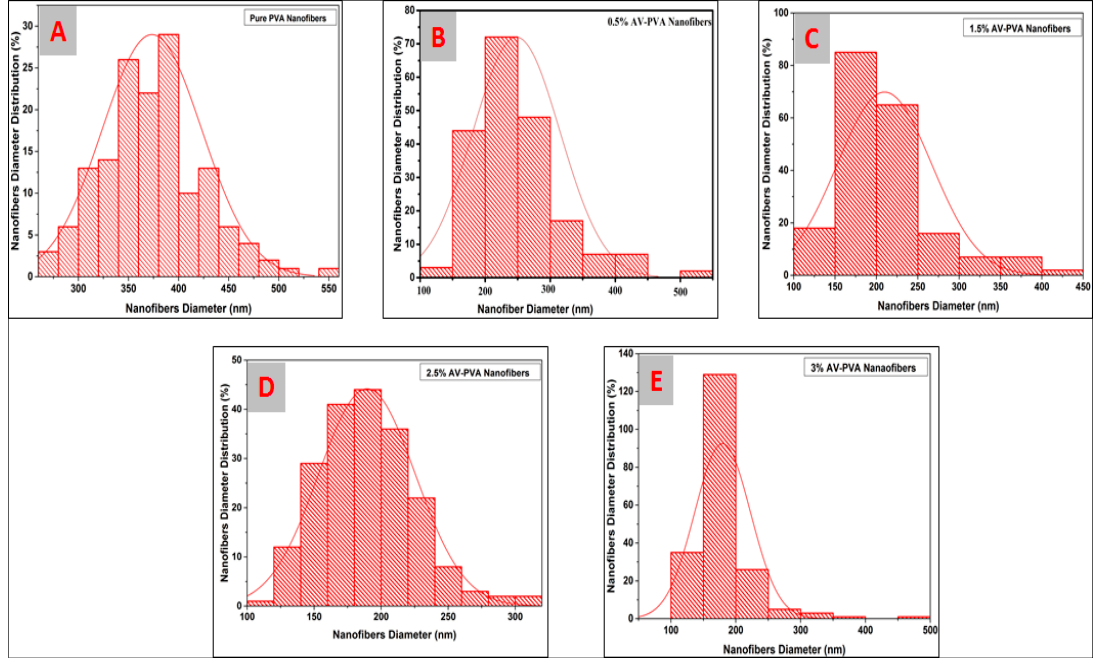
Figure 4. Diameter distribution of the developed electrospun nanofibers. ( A ) Pure PVA; ( B ) 0.5% AV/PVA; ( C ) 1.5% AV/PVA; ( D ) 2.5% AV/PVA; ( E ) 3%